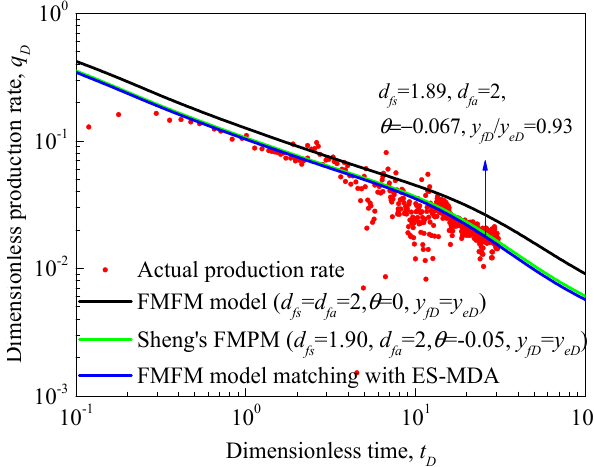
Figure 9. The matching results of actual shale gas production rate and different models.